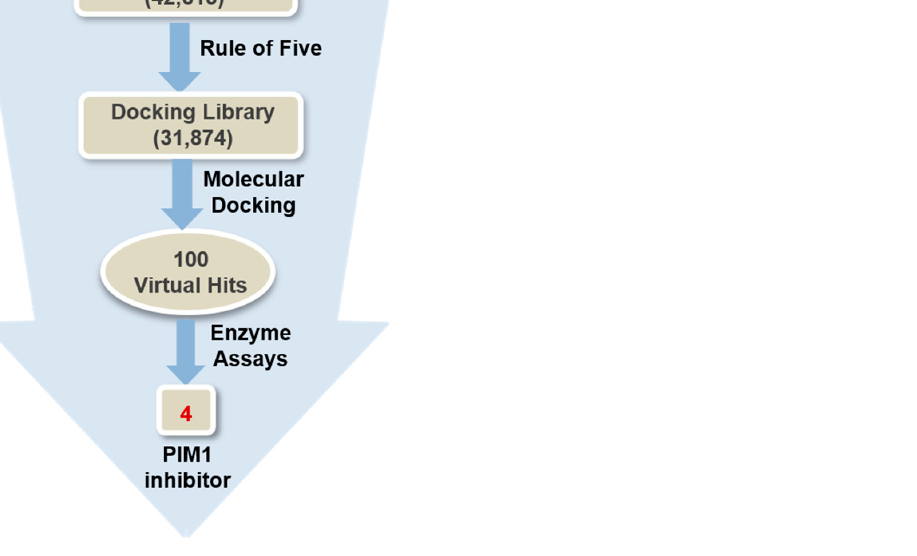
Figure 1. Flowchart for the discovery of PIM1 inhibitors of natural plant origin through virtual screening with in vitro enzyme assays.